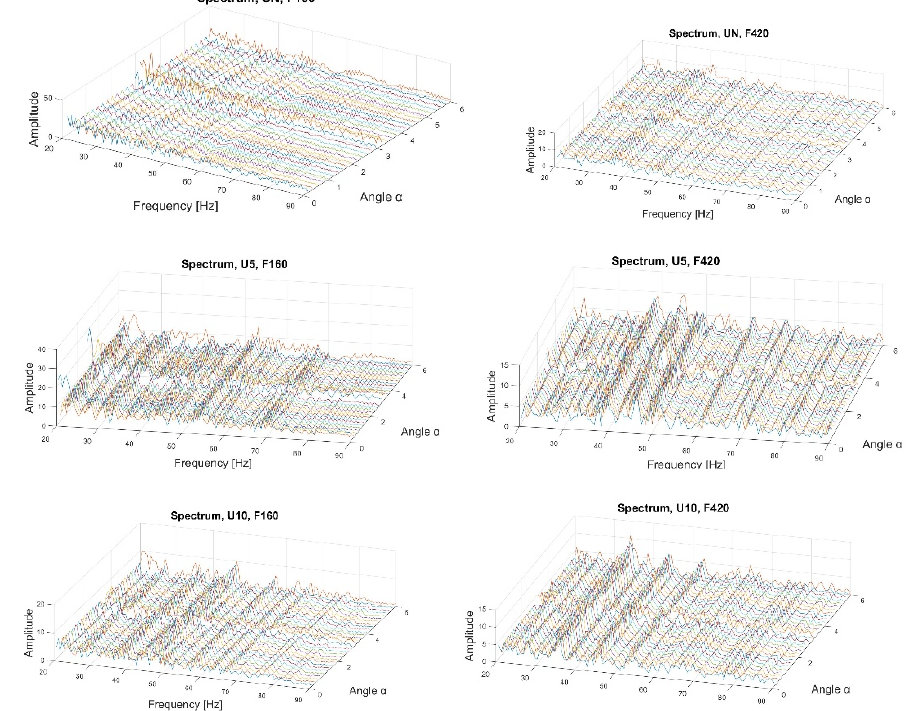
Figure 6. Envelope spectra of the generalized Hilbert transform.